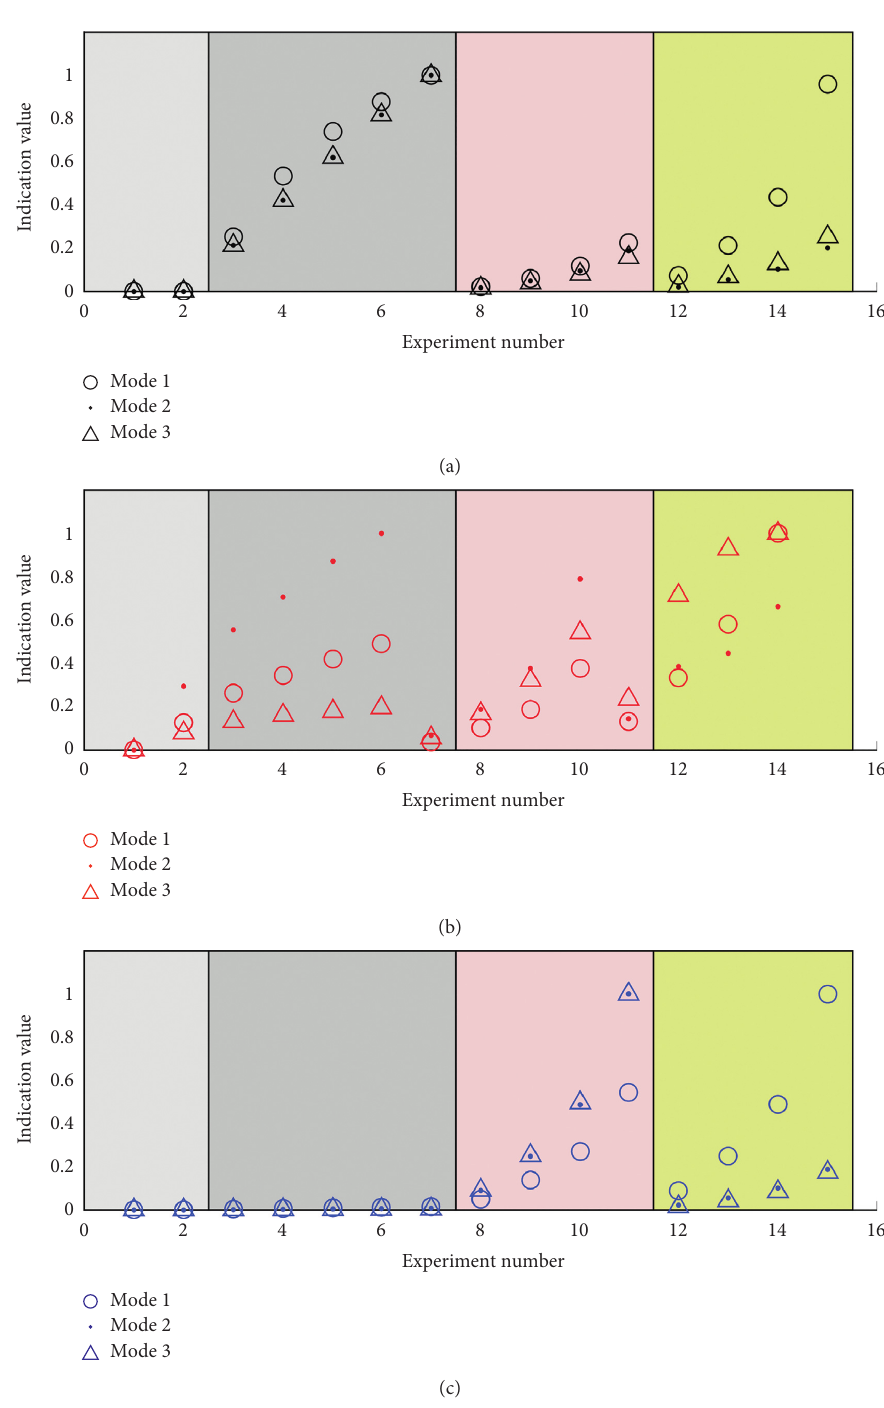
Figure 8: Results of damage detection for the first three modes: (a) MF method, (b) LMF method, and (c) WV method. Coloring of areas refers to damage scenarios under investigation, with temperature rise marked in grey and damage cases 1 and 2 marked with light and dark light red and yellow, respectively. Values are normalized so each time maximum indication of the given method would equal